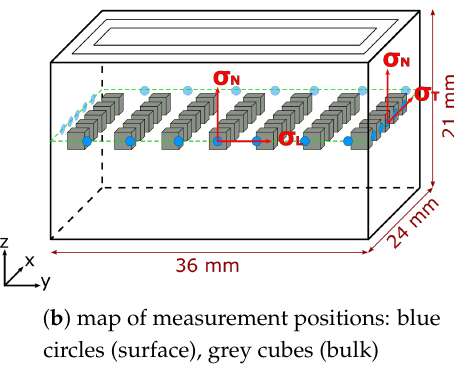
circles (surface), grey cubes (bulk)